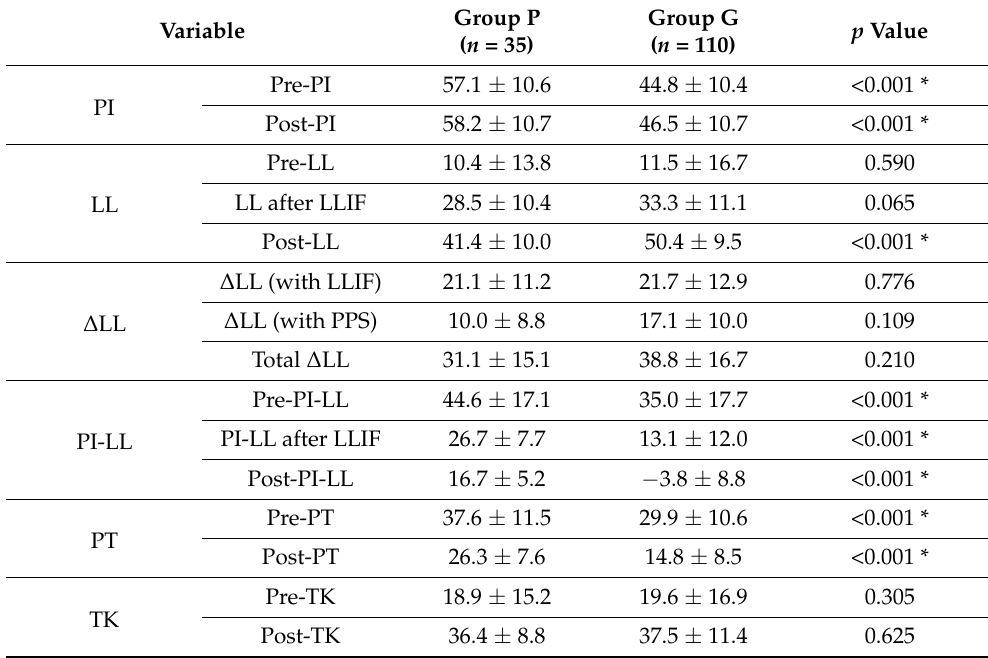
Table 4. Spinopelvic parameters (group P vs. group G).